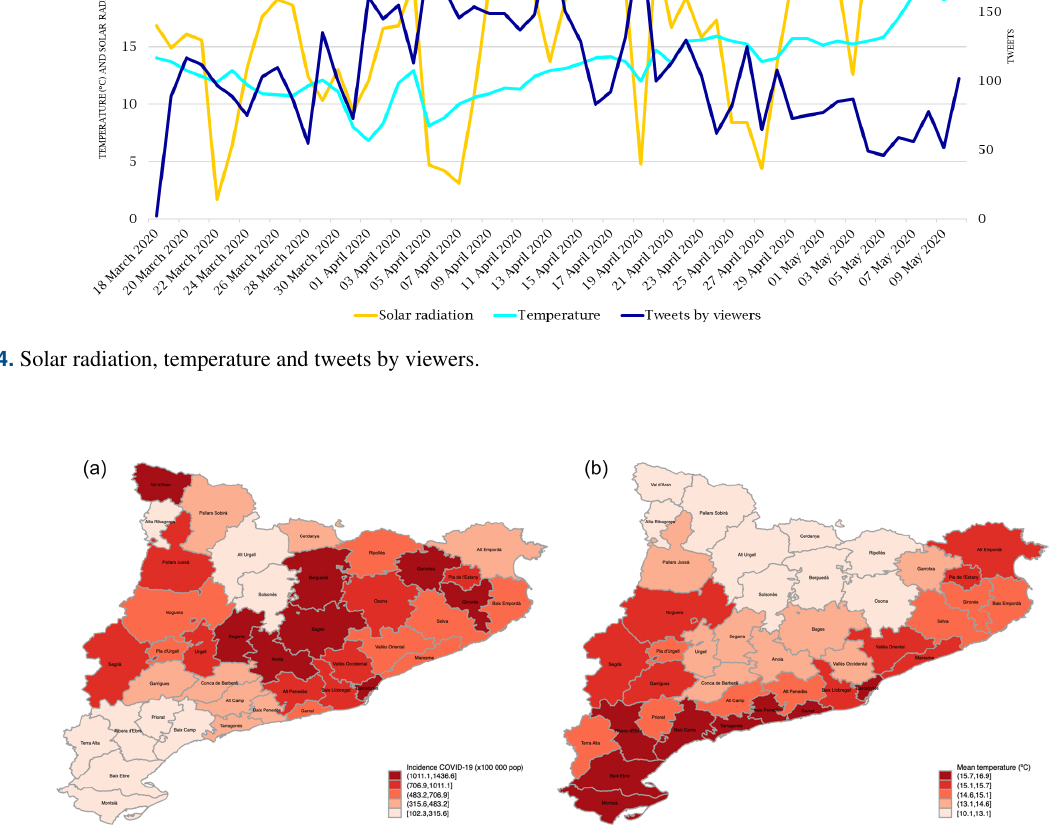
Figure 5. (a) COVID-19 incidence (cases per 100000 pop.); (b) Mean temperature ( ◦ C) (Tobias et al.,